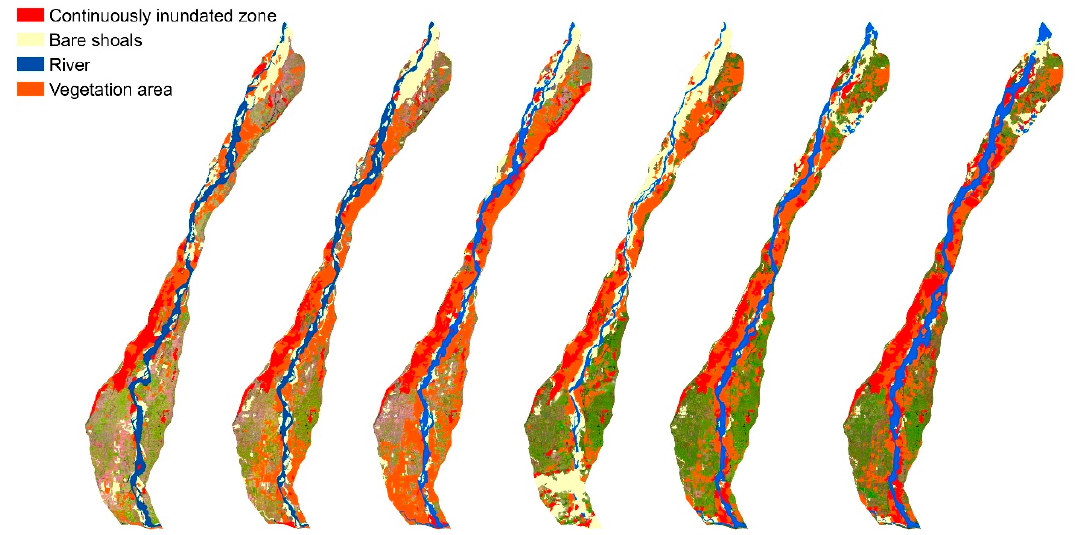
Figure 3. Wetland areas in the wet seasons of 2014–2019: the bare shoals are referred to as exposed areas in a river without vegetation, but flooded by water from time to time. The continuously inundated area was identified as areas covered by water for most of the year. The vegetation area was the zone covered by plants, primarily by reeds. Water 2020 , 12 , x FOR PEER REVIEW